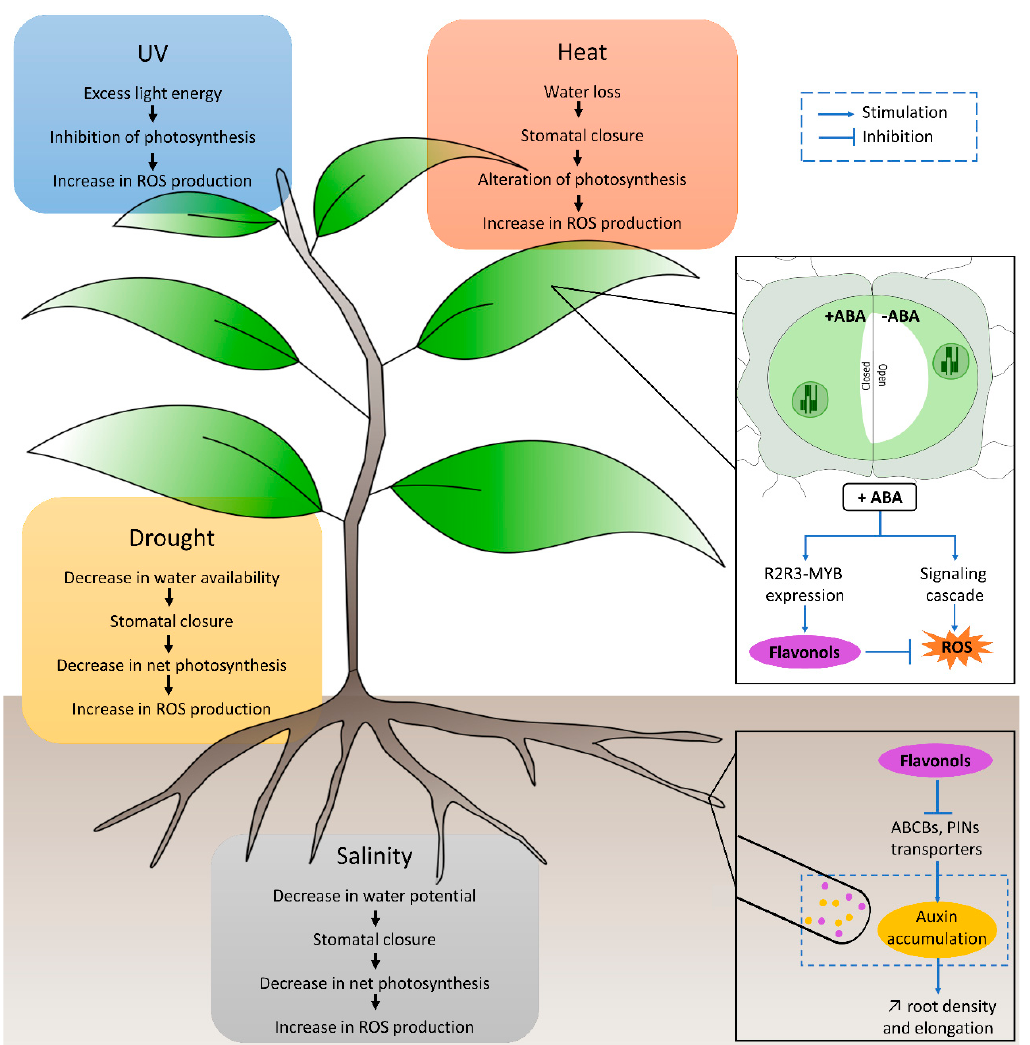
Figure 3. Plant responses to abiotic stress. The colored boxes summarize the four abiotic stresses referred to in this review and their main consequences for plant physiology. Flavonols’ role as ROS scavengers and their interaction with the phytohormones ABA in leaves and auxin in roots is shown in black boxes. In leaves, the opening of stomata is allowed by the binding of ABA to membrane receptors resulting in an efflux of ions and therefore an efflux of water leading to stomata closure. ABA act on the R2R3-MYB gene by enhancing its expression thus stimulating flavonol biosynthesis. It also triggers a signaling cascade leading to ROS production. In roots, flavonols inhibit auxin transport leading to auxin accumulation and root elongation.